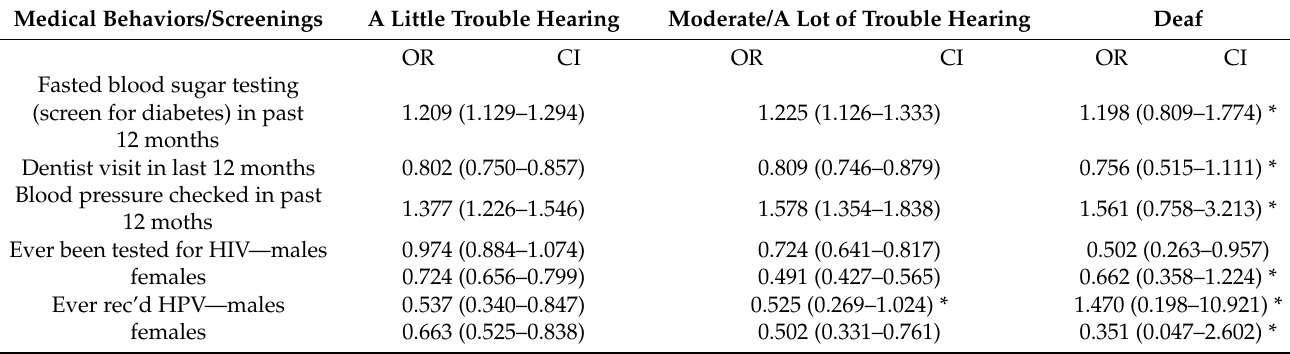
Table 4. Comparison of medical/screening behaviors by level of hearing loss to excellent/good hearing status. Medical